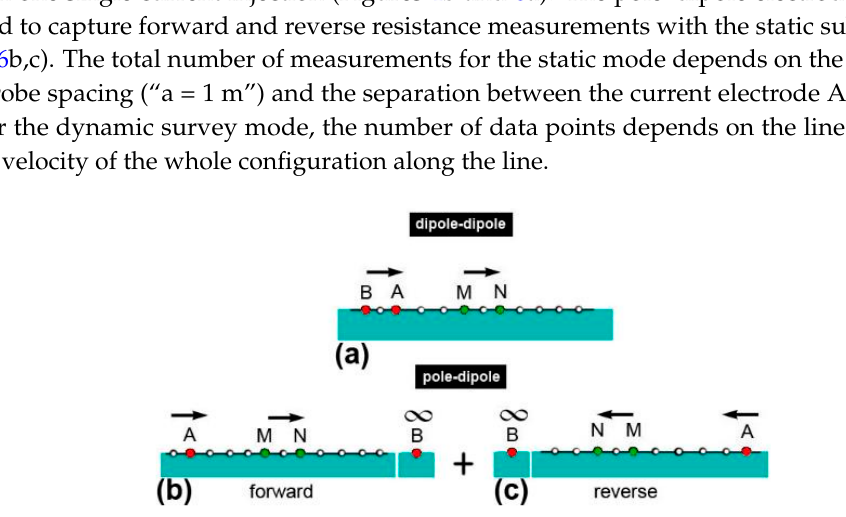
Figure 6. Configurations used for data collection: ( a ) Dipole–dipole and ( b , c ) Pole–dipole (forward +